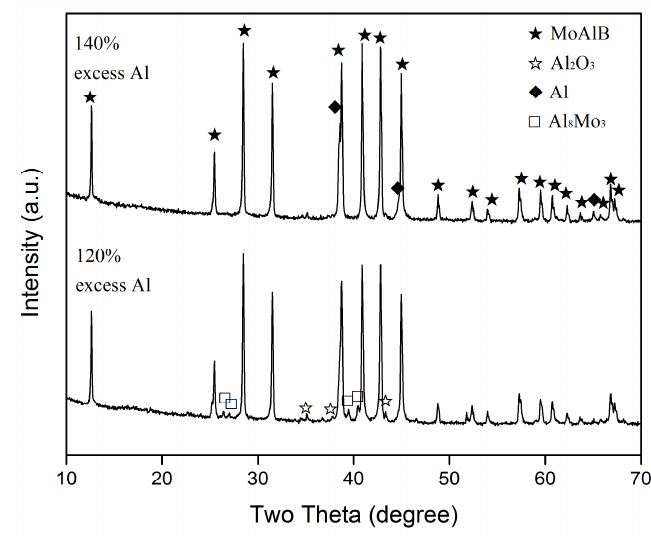
Figure 4. XRD patterns of samples with 120% and 140% excess Al, separately, after 6 h of firing at 1000 °C.